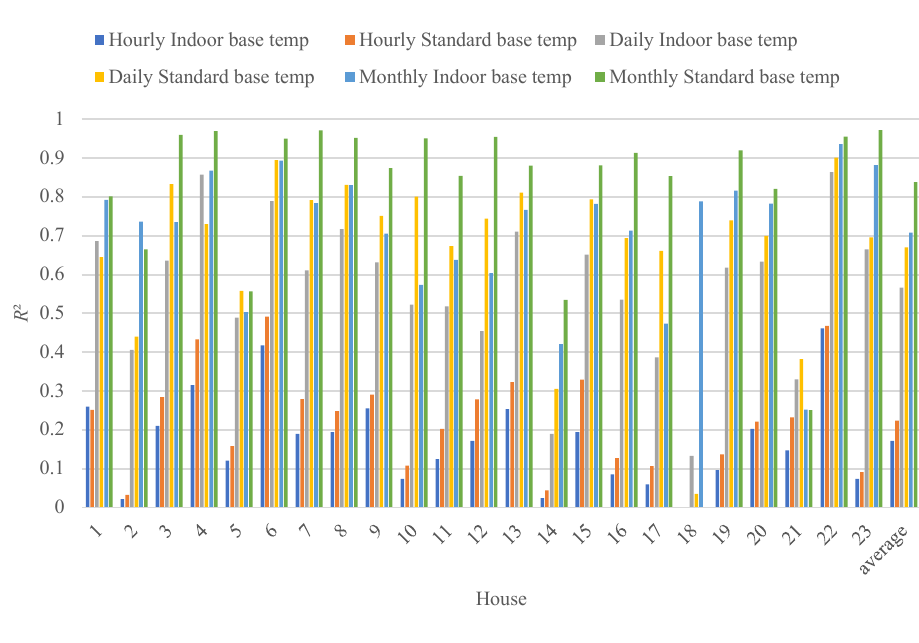
Fig. 5. Coefficient of determination R 2 for all houses at each base temperature in hourly, daily and monthly